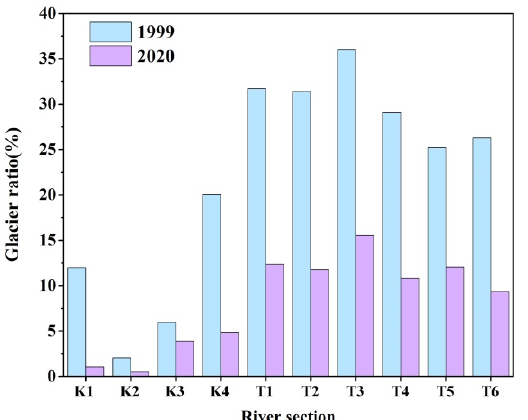
Figure 5. The proportion of glacier area in the basins of different river sections in 1999 and 2020.